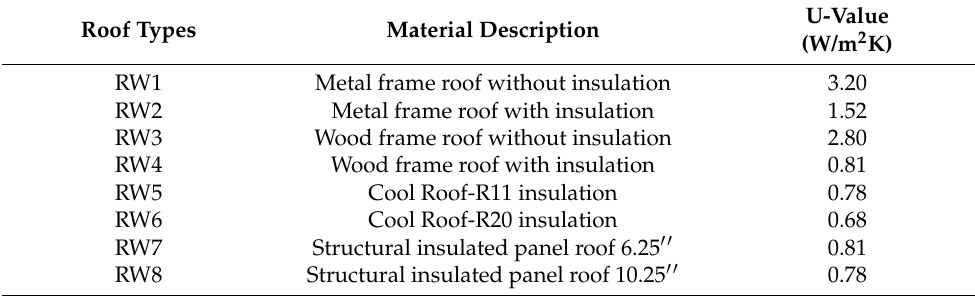
Table 7. Different types of roof materials for warehouse